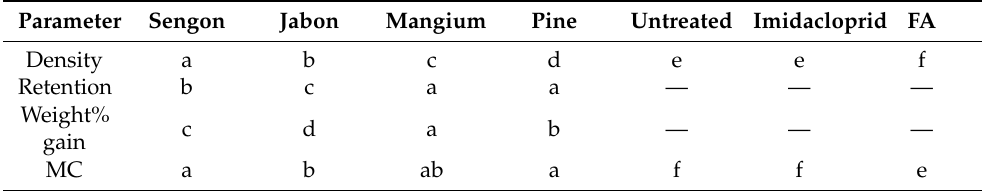
Table 4. Duncan’s multiple range test of density, WPG, retention, and MC.